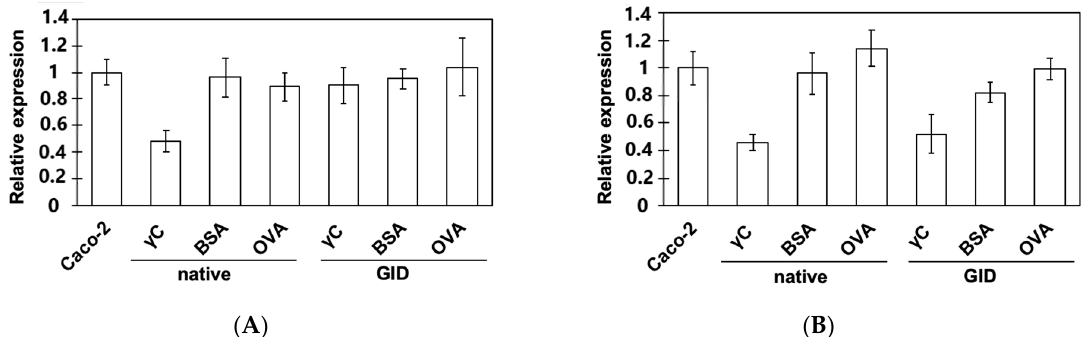
Figure 3. The modulation of intestinal peptide transporter gene expression in the Caco-2 cells of γ C, determined by RT-qPCR. ( A ) Expression modulation of the Pept-1 transporter. ( B ) Expression modulation of the Hpt-1 transporter. Chicken ovalbumin (OVA) and bovine serum albumin (BSA) were also tested. Proteins have been tested in native conditions and after simulated gastrointestinal digestion (GID). Caco-2 are untreated cells.